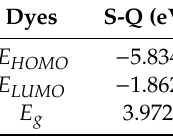
Table 2. Molecular descriptor parameters of S-Q and S-R.